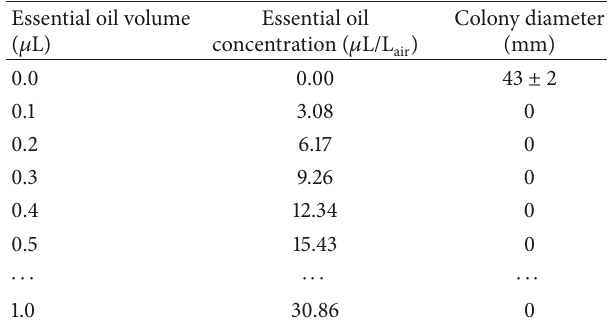
Table 1: Aspergillus niger colony diameter after 10 d of incubation in the presence of mustard essential oil (inverted Petri dish